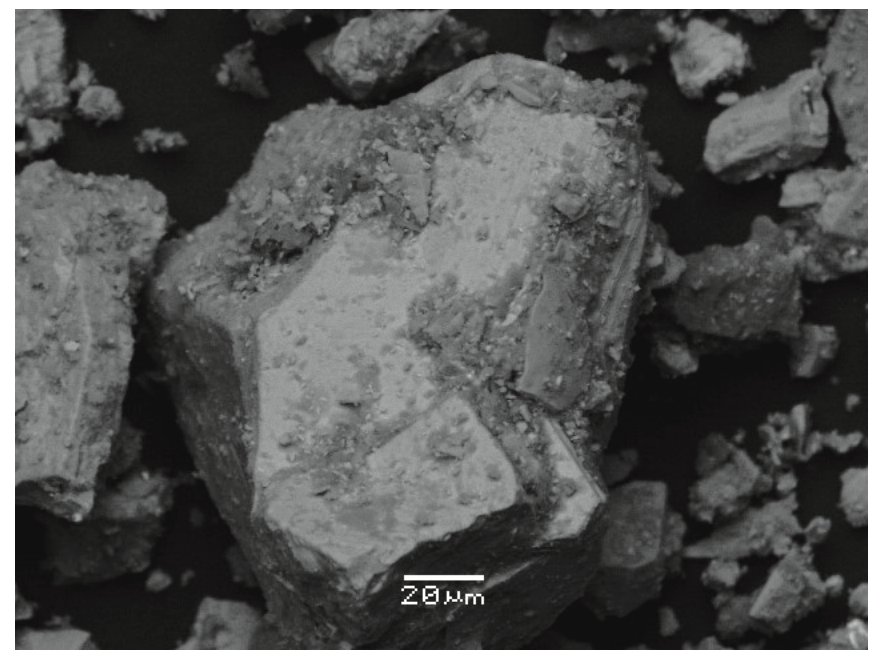
Figure 3. BSE image of free pyrite grain in Olympias Py-AsPy concentrate.